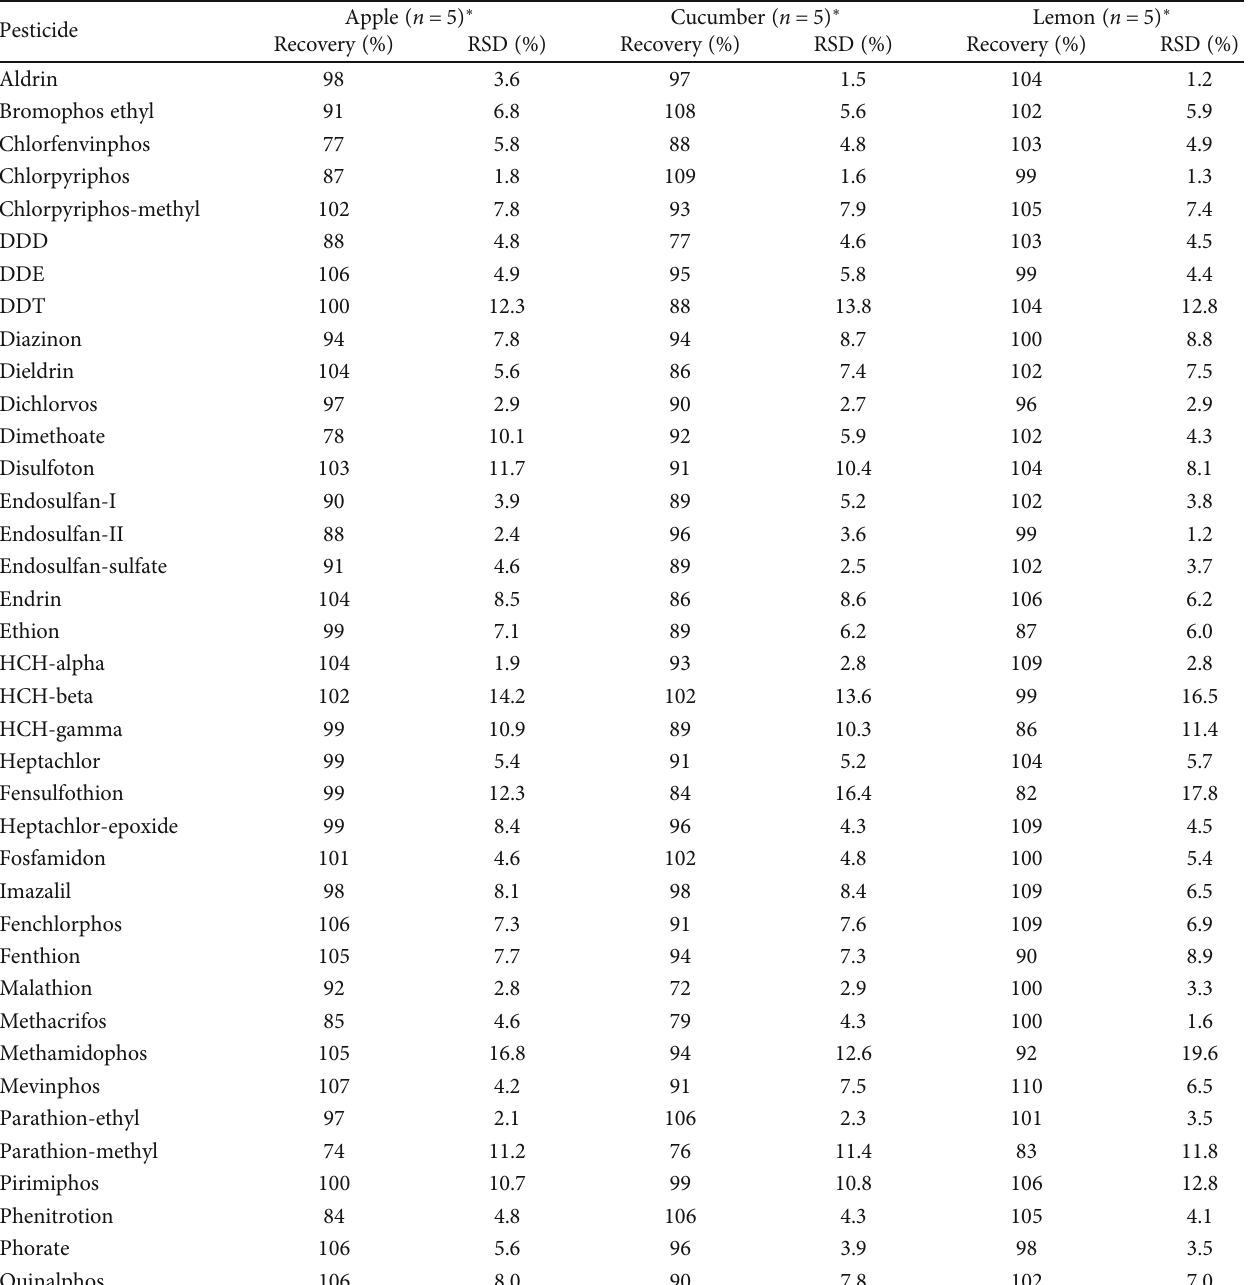
Table 1: Validation results: mean recovery and relative standard deviation from three representative samples (apple, cucumber, and lemon) inoculated with 0.1 μ g/ml to 0.25 μ